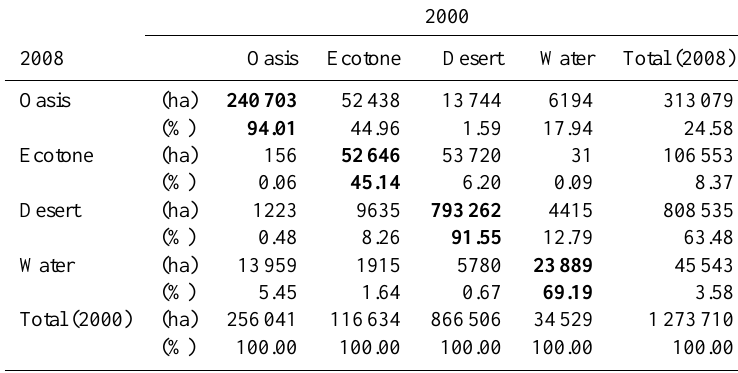
Table 5. The conversion (change) matrix of land cover change from 2000 to 2008 ∗